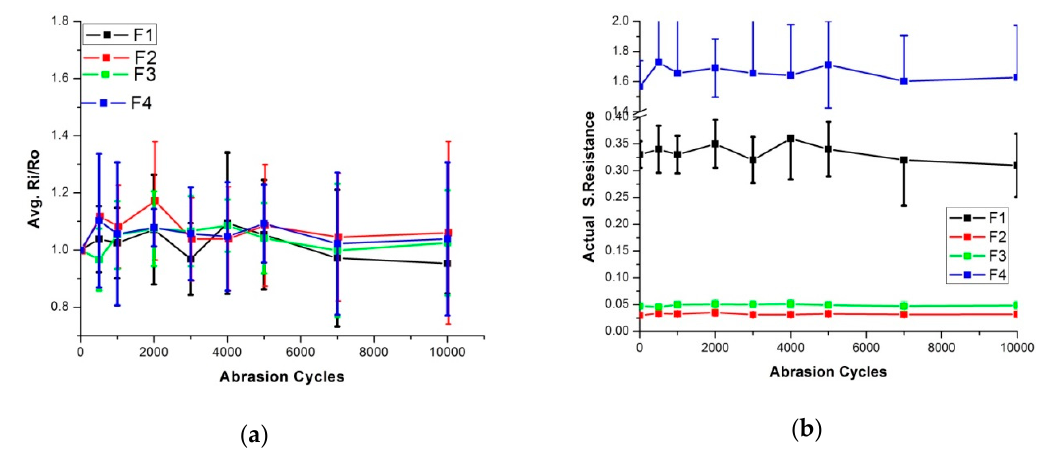
Figure 13. Surface resistance analysis after abrasion cycles, ( a ) Comparison of Ri/Ro ( b ) comparison of actual resistance.